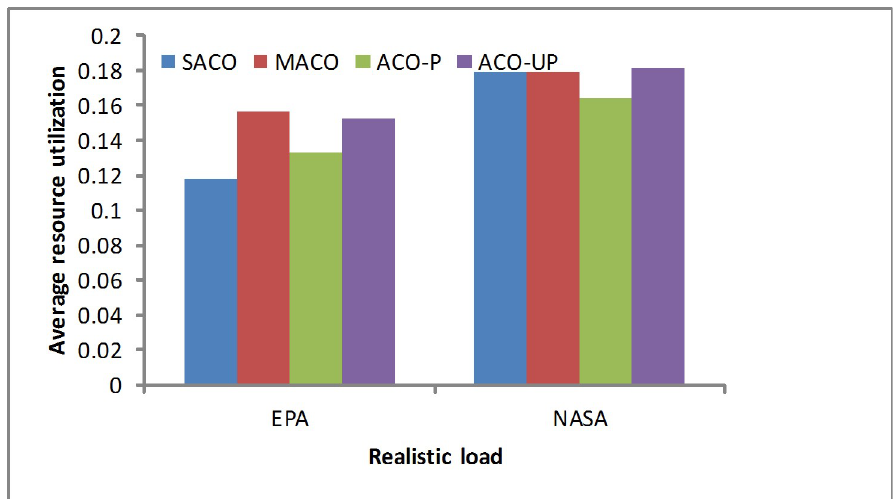
Fig 10. CPU resource utilization under the realistic